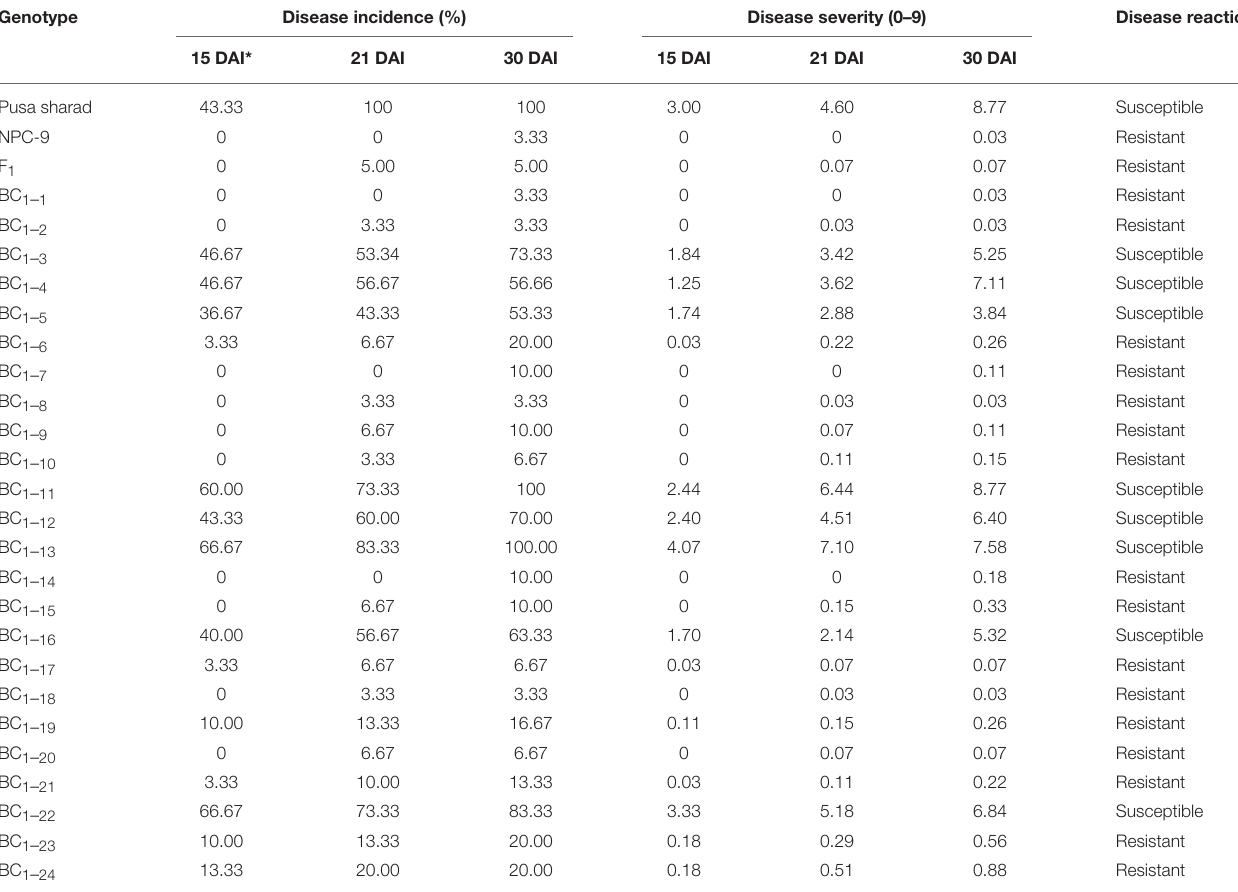
TABLE 3 | Phenotyping for black rot disease Xcc race 1 in parental, F 1 and back crossed individuals derived from in vitro embryo rescue. Genotype Disease incidence (%) Disease severity (0–9) Disease